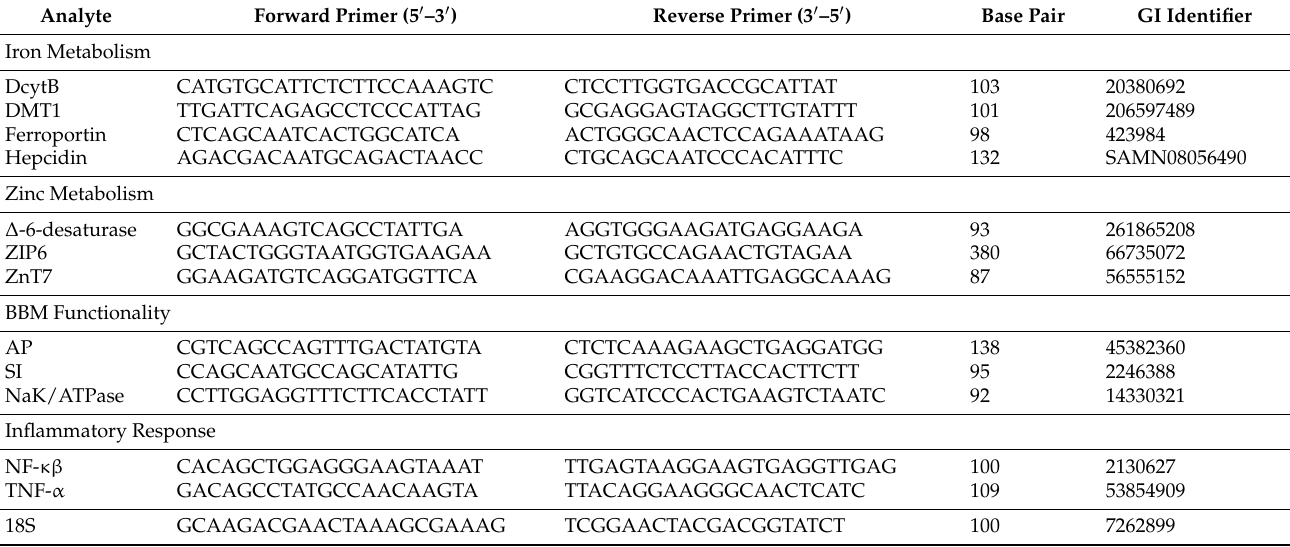
Table 1. Sequences of primers used in this